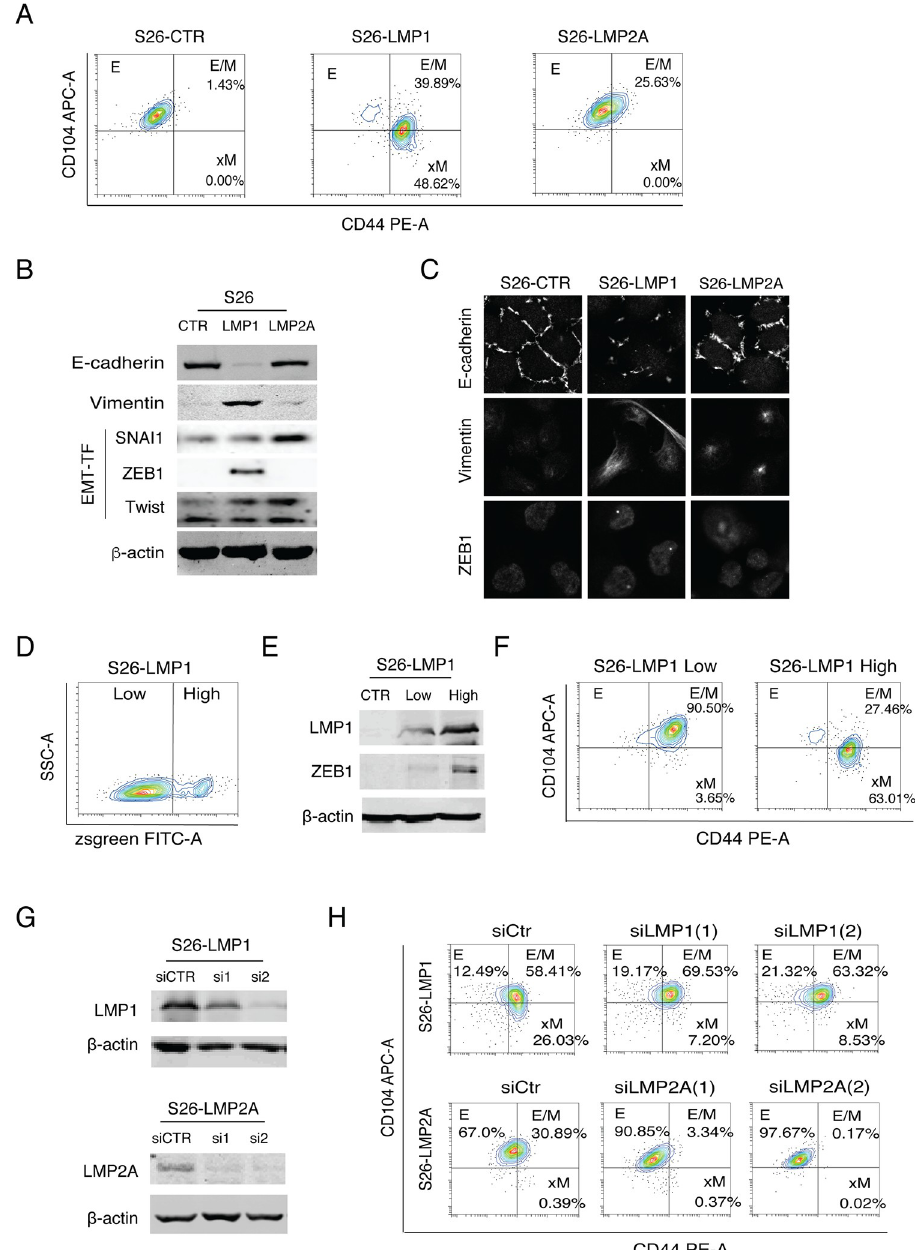
Fig 3. Effects of LMP1 and LMP2A expression on the generation of distinct subpopulations in the epithelial- mesenchymal spectrum. ( A) The changes of CD44 and CD104 profiles of S26 cells in response to LMP1 and LMP2A expression revealed by flow cytometry analysis. ( B) The expression of EMT markers (E-cadherin, Vimentin) and EMT-TFs (SNAI1, Twist, ZEB1) in S26-CTR, S26-LMP1, and S26-LMP2A cells were analyzed by Western blot. β -actin was included as a loading control. (C) Immunofluorescence assay of S26 cells (S26-CTR) and S26 cells expressing LMP1 (S26-LMP1) or LMP2A (S26-LMP2A) cells for the expression and subcellular localization of E-cadherin, Vimentin, and ZEB1 (630x). ( D) S26 cells were transfected with a pLVX-EF1 α -IRES-Zsgreen1-LMP1 plasmid that simultaneously expresses LMP1 and Zsgreen from a single mRNA transcript. LMP1 high and LMP1 low subpopulations were separated and isolated by FACS based on the fluorescence intensity of Zsgreen. ( E) The LMP1 and ZEB1 expression levels in these two subpopulations were analyzed by Western blotting. ( F) The epithelial-to-mesenchymal states of LMP1 high and LMP1 low subpopulations were determined on their CD44 and CD104 expression profiles. (G) S26-LMP1 and S26-LMP2A cells were transfected siRNAs to knock down the expression of LMP1 and LMP2A respectively. The knockdown efficiency of siRNAs was analyzed by Western blot. (H) The effects of LMP1 and LMP2A knockdown on CD44 and CD104 profile were analyzed by flow cytometry analysis.